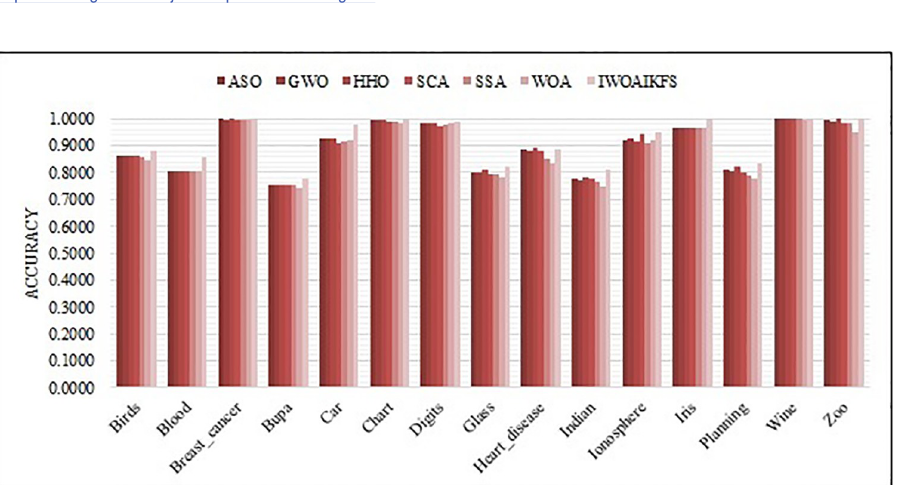
Fig 8. Total mean accuracy of IWOAIKFS compared to other algorithms under all datasets.